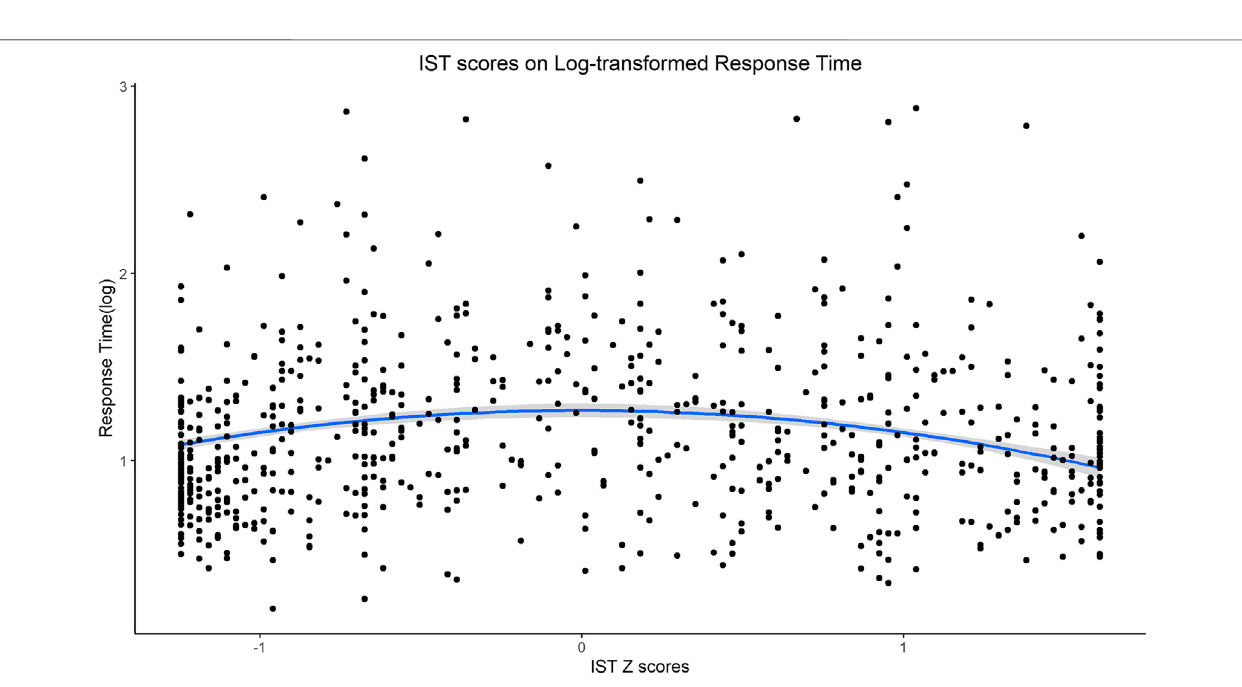
Frontiers in Robotics and AI |